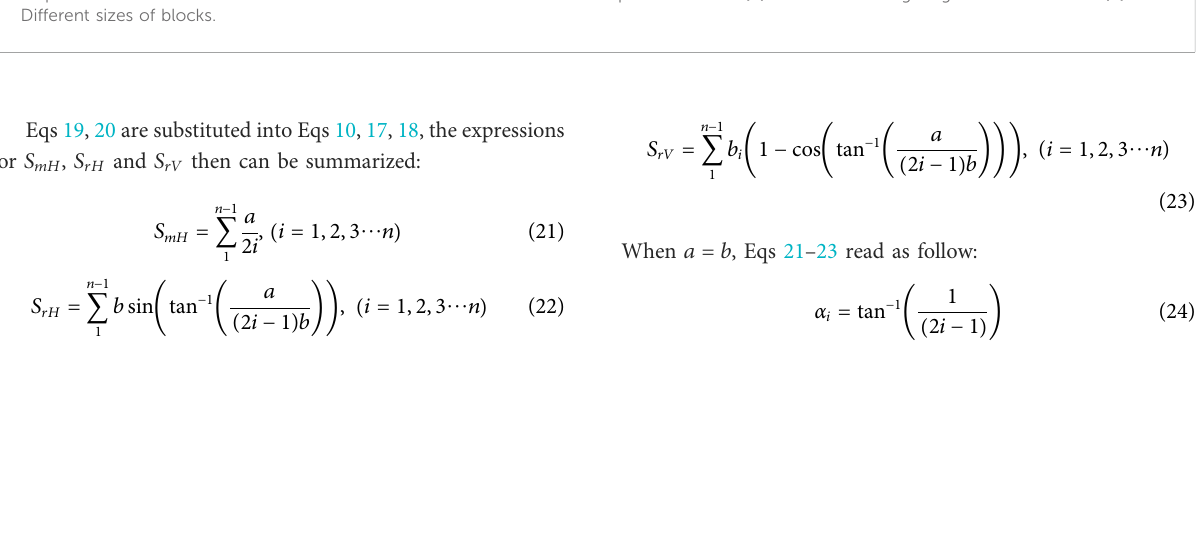
FIGURE 16 Displacement variation of rock blocks of the rotation motion in the limit equilibrium state. (A) Different stacking heights of rock blocks. (B) Different sizes of